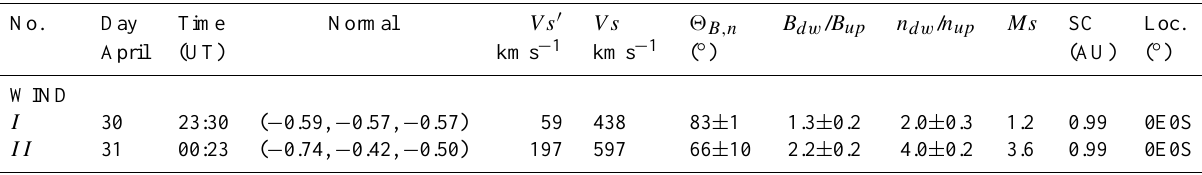
Table 2. Similar to Table 1, but for the shocks in the March 2001 event. Vector quantities are given in GSE system. S I is evaluated using Wind data, and S II is evaluated using ACE